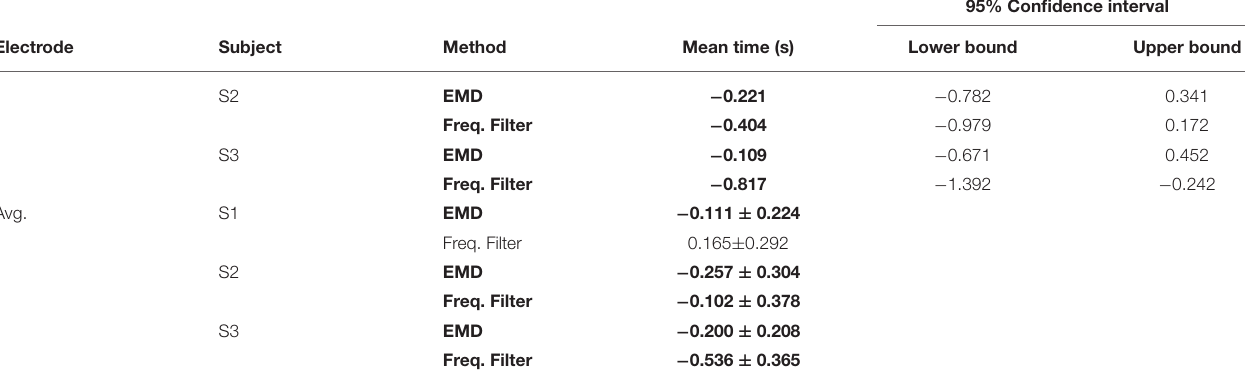
Frontiers in Neurorobotics |